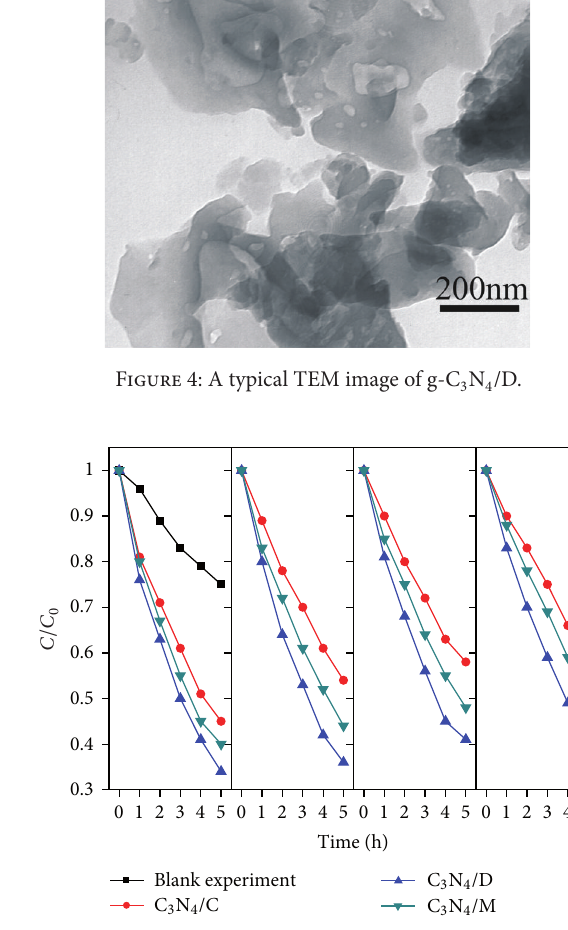
F 5: Photodegradation of MB over the g-C